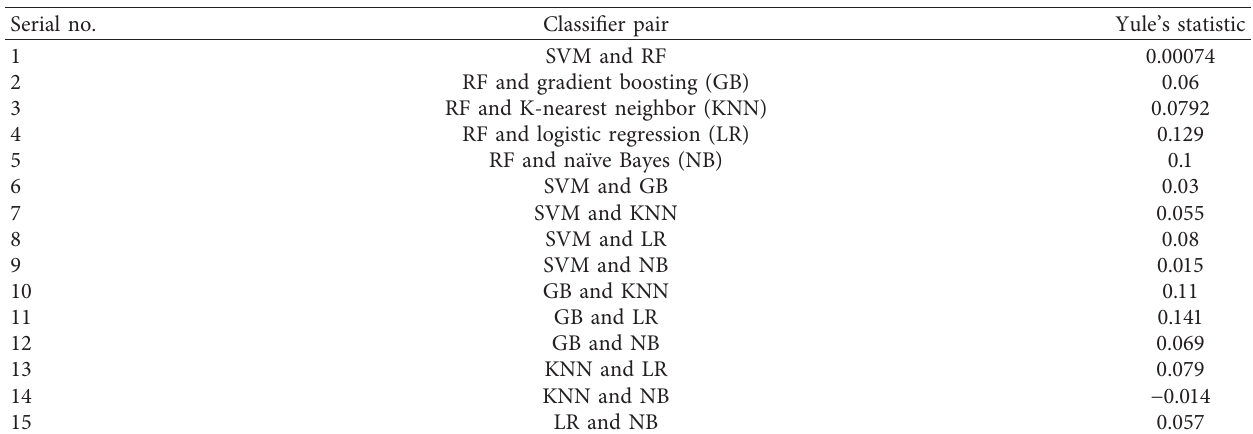
Table 3: Yule’s statistic for different classifier